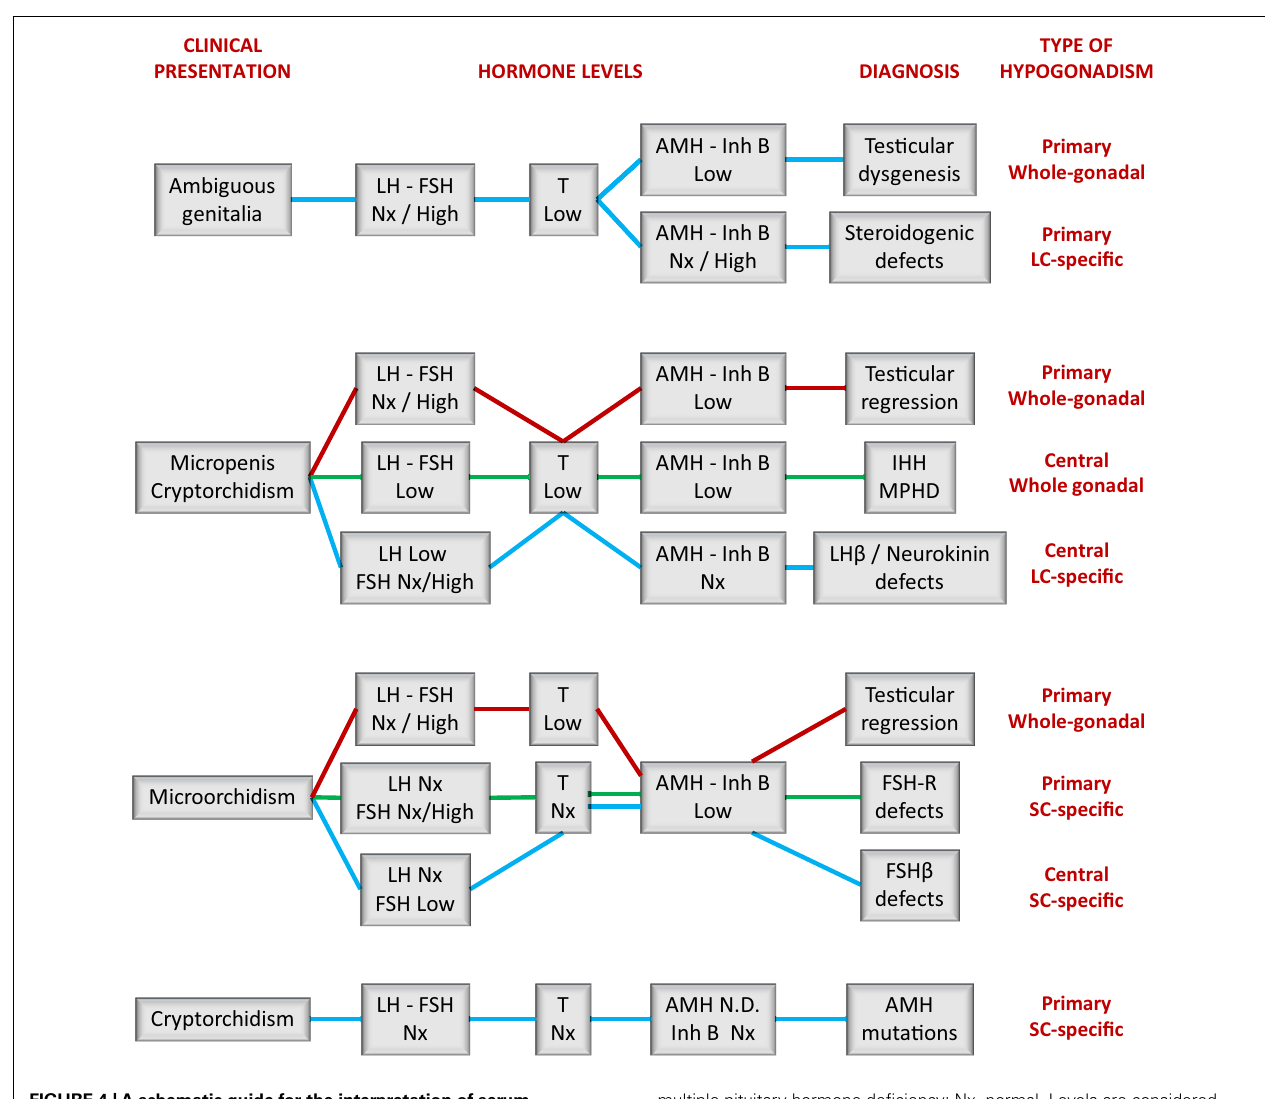
FIGURE 4 |A schematic guide for the interpretation of serum hormone levels in patients with fetal-onset male hypogonadism . IHH, isolated hypogonadotropic hypogonadism; Inh B, inhibin B; MPHD,